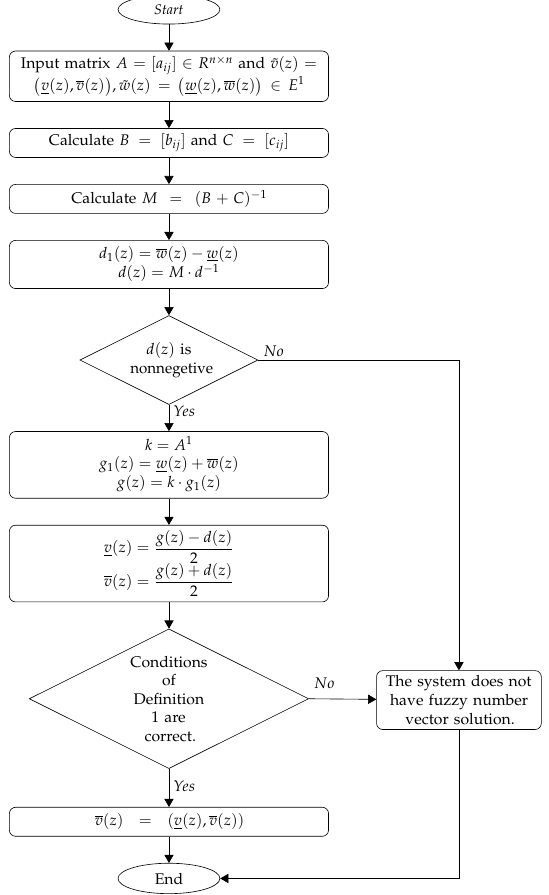
Figure1. FlowchartofAlgorithm1. Figure 1. Flowchart of Algorithm